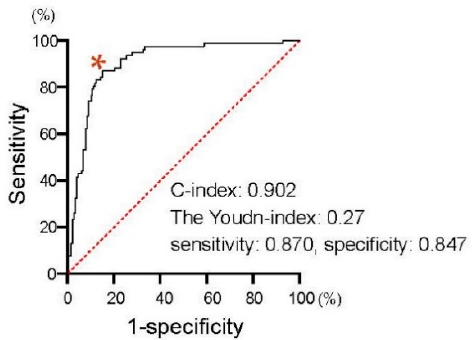
Figure 3. Receiver operating characteristic (ROC) curves to determine the optimal cut-off in PSA changes at four weeks of the treatment for the event of achieving PSA30D at 12 weeks. The Youden-index, the point maximizing the difference between the true-positive and false-positive rates across all possible cut-off values, was indicated at * mark.